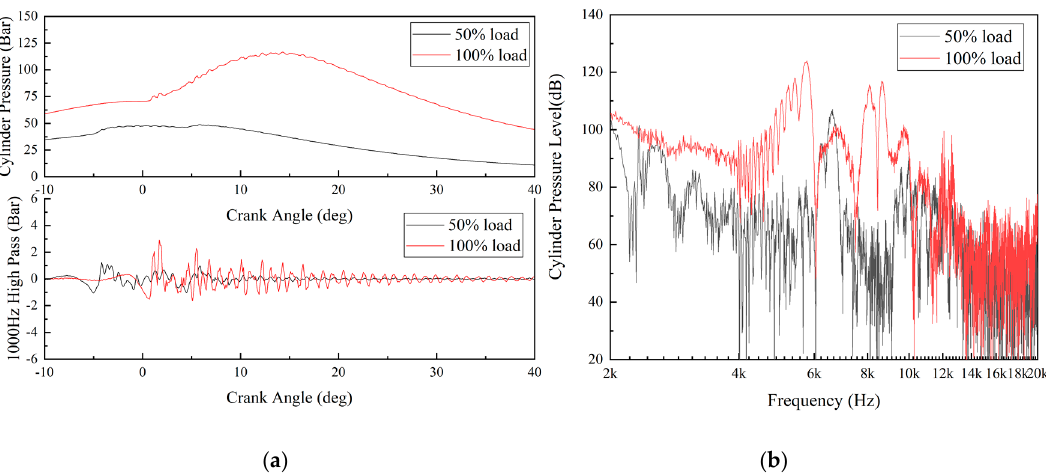
Figure 18. Cylinder pressure in ( a ) angle domain and ( b ) frequency domain of different loads.